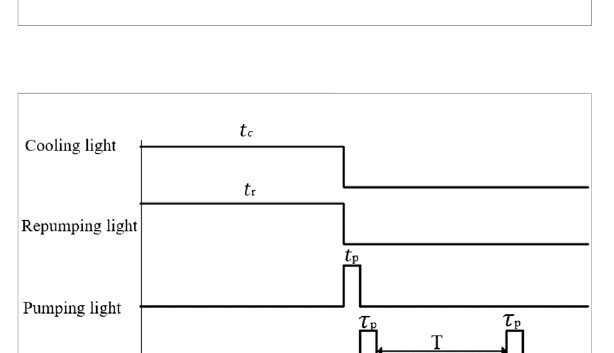
FIGURE 4 Assembled cold atom clock for satellite applications. The bottom shows electronics, top left shows the optical system, and top right shows the physics package.